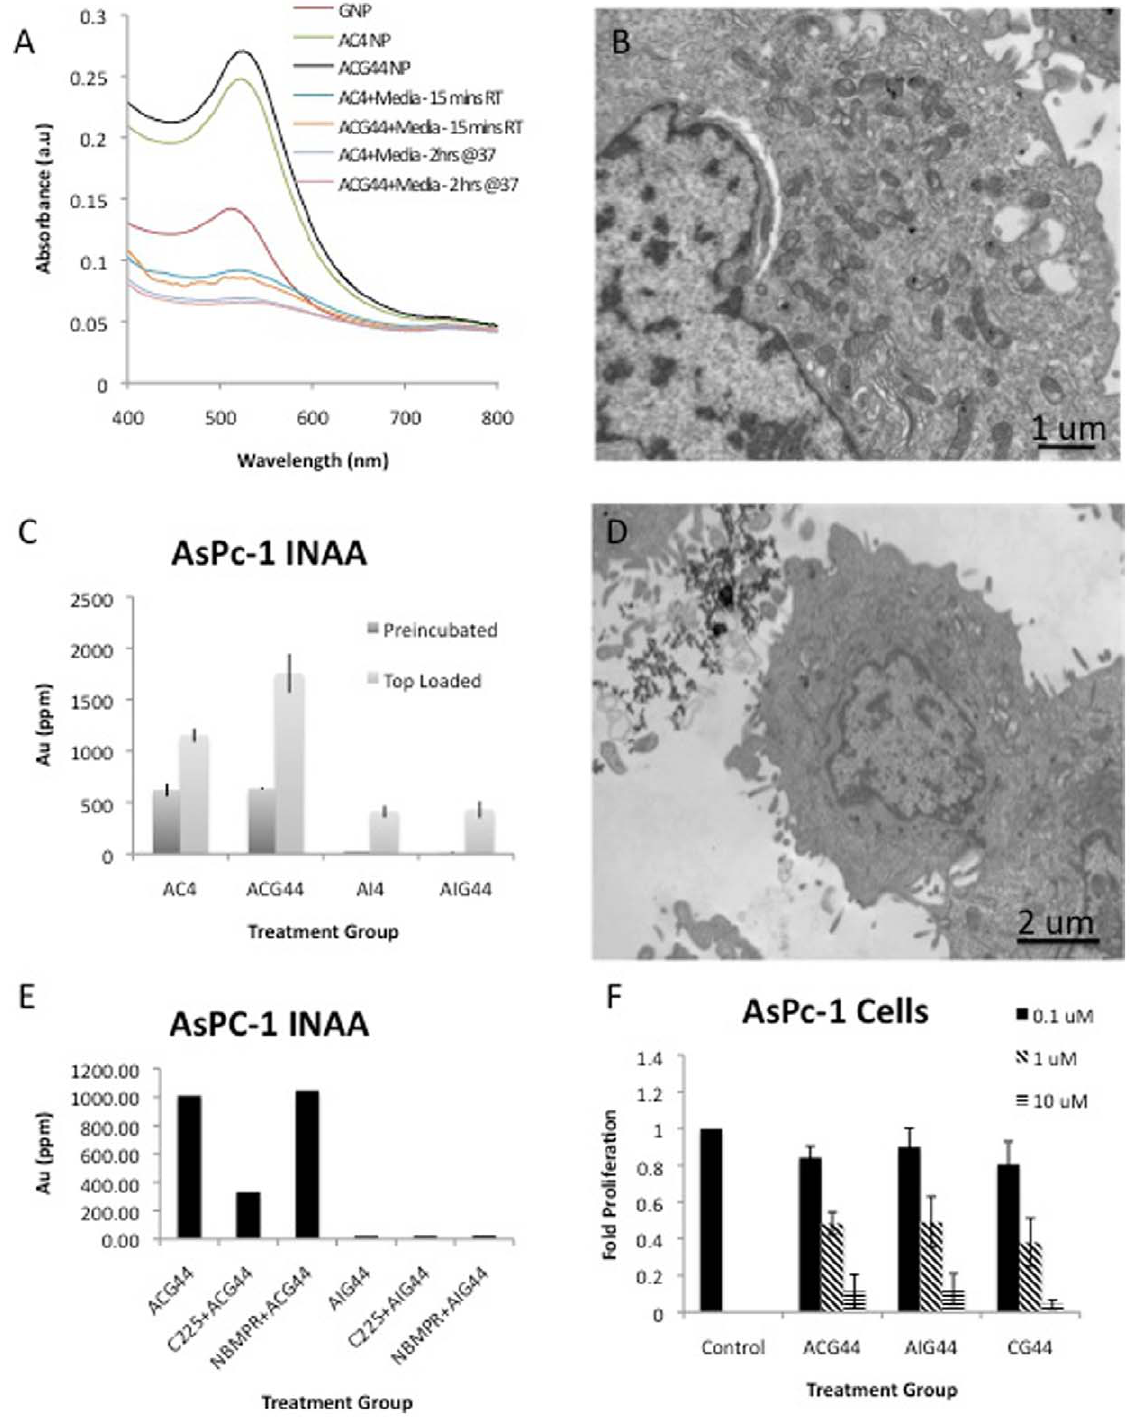
Figure 2. Role of pre-incubation with serum, C225 and NBMPR on targeting efficacy of gold nanoconjugates and their invitro biological function. Figure 2A depicts the absorbance spectrums of GNP, AC4 and ACG44 before and after pre-incubation with serum either 15 minutes at room temperature or 2 hrs at 37 u C. Figure 2B and 2D are transmission electron microscopy images of the in vitro uptake of ACG44 and AIG44 in AsPC-1 cells, respectively. Figure 2C describes the effect of pre-incubation with serum on the cellular uptake of the nanoconjugates into AsPC-1 cells analyzed for gold content utilizing INAA. Figure 2E also depicts INAA analysis of cellular uptake of ACG44 and AIG44 in AsPC-1 cells, both with/without pre-incubation with C225 or NBMPR to demonstrate possible uptake mechanisms. Figure 2F shows the anti-proliferative effect of ACG44, AIG44 and CG44 on AsPC-1 cells determined through 3 H-thymidine incorporation.